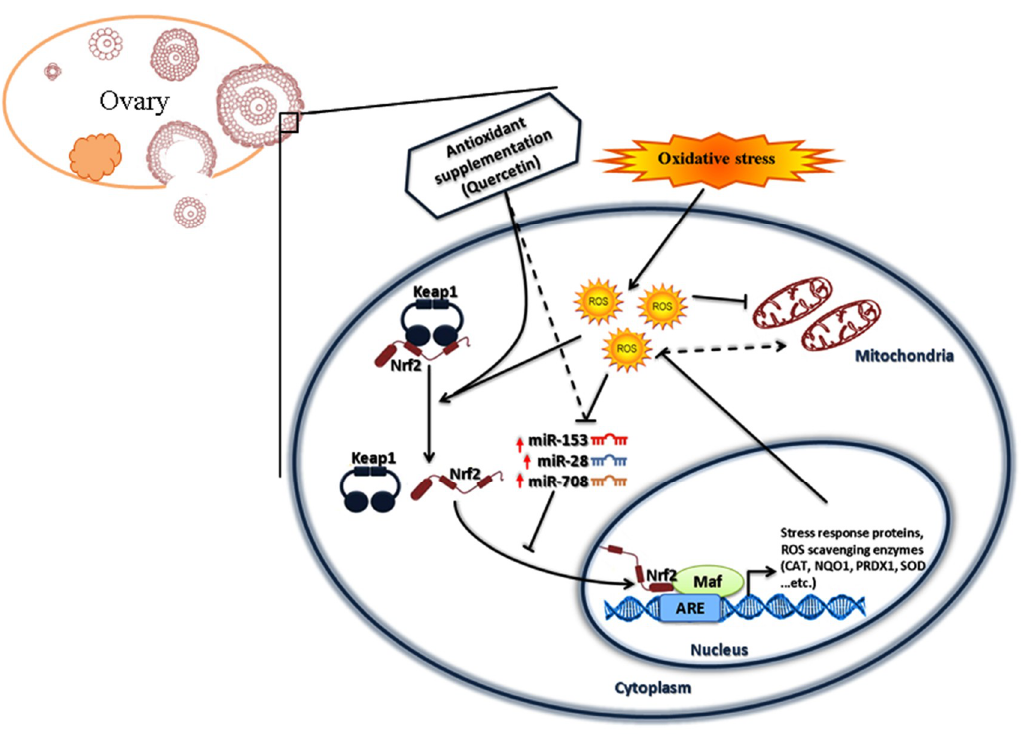
Figure 10. Model of the Nrf2-mediated oxidative stress response pathway in bovine granulosa cells under moderate oxidative stress conditions and under antioxidant (quercetin) supplementation. Oxidative stress and Que modulate Nrf2 post transcriptionally through the inhibition of miR-153, miR-28 and miR-708, which targeted bovine Nrf2 . After that, Nrf2 protein was activated and localized to the nucleus, where it binds to the antioxidants reactive element (ARE) in the promoters of antioxidant genes. This activates antioxidant gene expression so the respective proteins can scavenge the excessive ROS and subsequently maintain the activity of